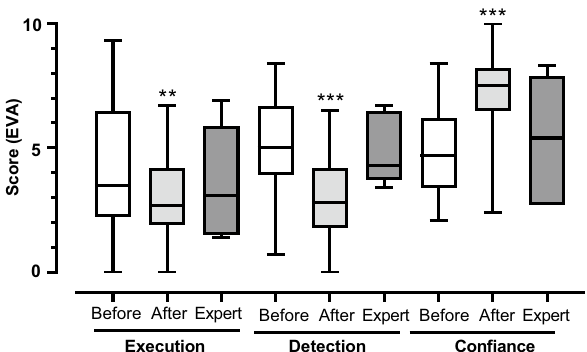
Figure 3. Difficulty of test execution, of saccade detection and detection confidence level estimated by visual analogue score among novices before and after training and in experts. The boxes represent the 95-percentile confidence interval, the horizontal bar the mean and the whiskers the range. **p < 0.03 and ***p < 0.001, two- way ANOVA followed by Bonferroni